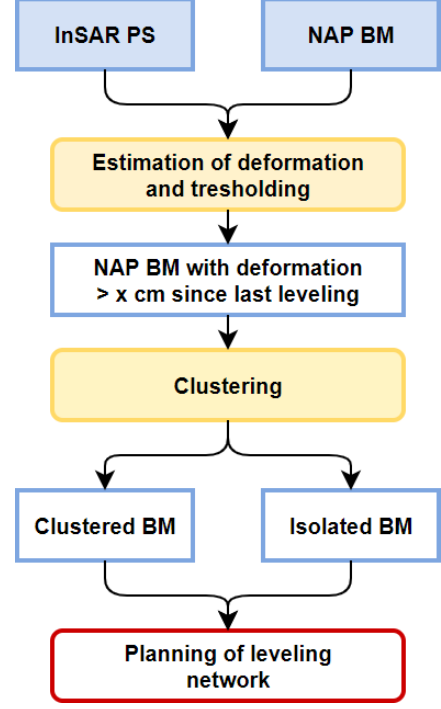
Figure 1. Schematic overview of the InSAR based planningtool.